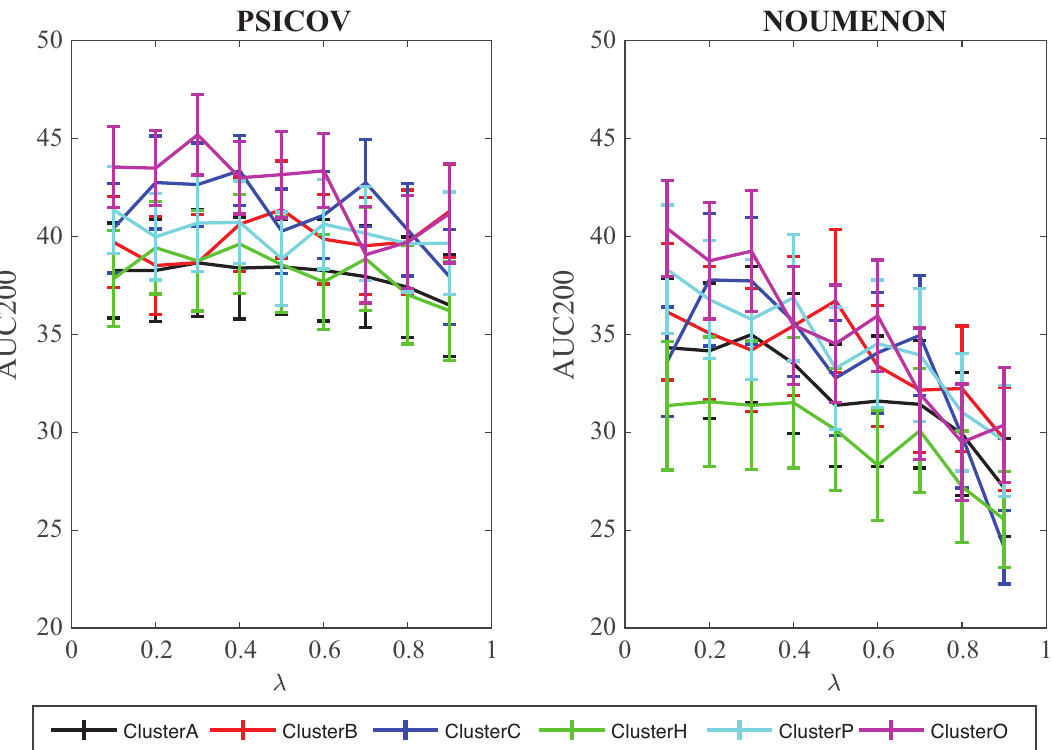
Figure 4. Performance of GaussCovar with 1D representations of amino acids over the PSICOV dataset ( left ) and the NOUMENON dataset ( right ). The predictive power of GaussCovar was tested using one of 402 amino acid properties available in the database AAindex [40,41]. Results are presented as averages over 6 groups of AAIndex1 scales, as originally defined in [45]. The 6 clusters A, B, C, H, P, and O correspond to indices related to alpha helix and turn propensities, beta sheet propensities, amino acid composition, hydrophobicity , physicochemical properties, and other properties,